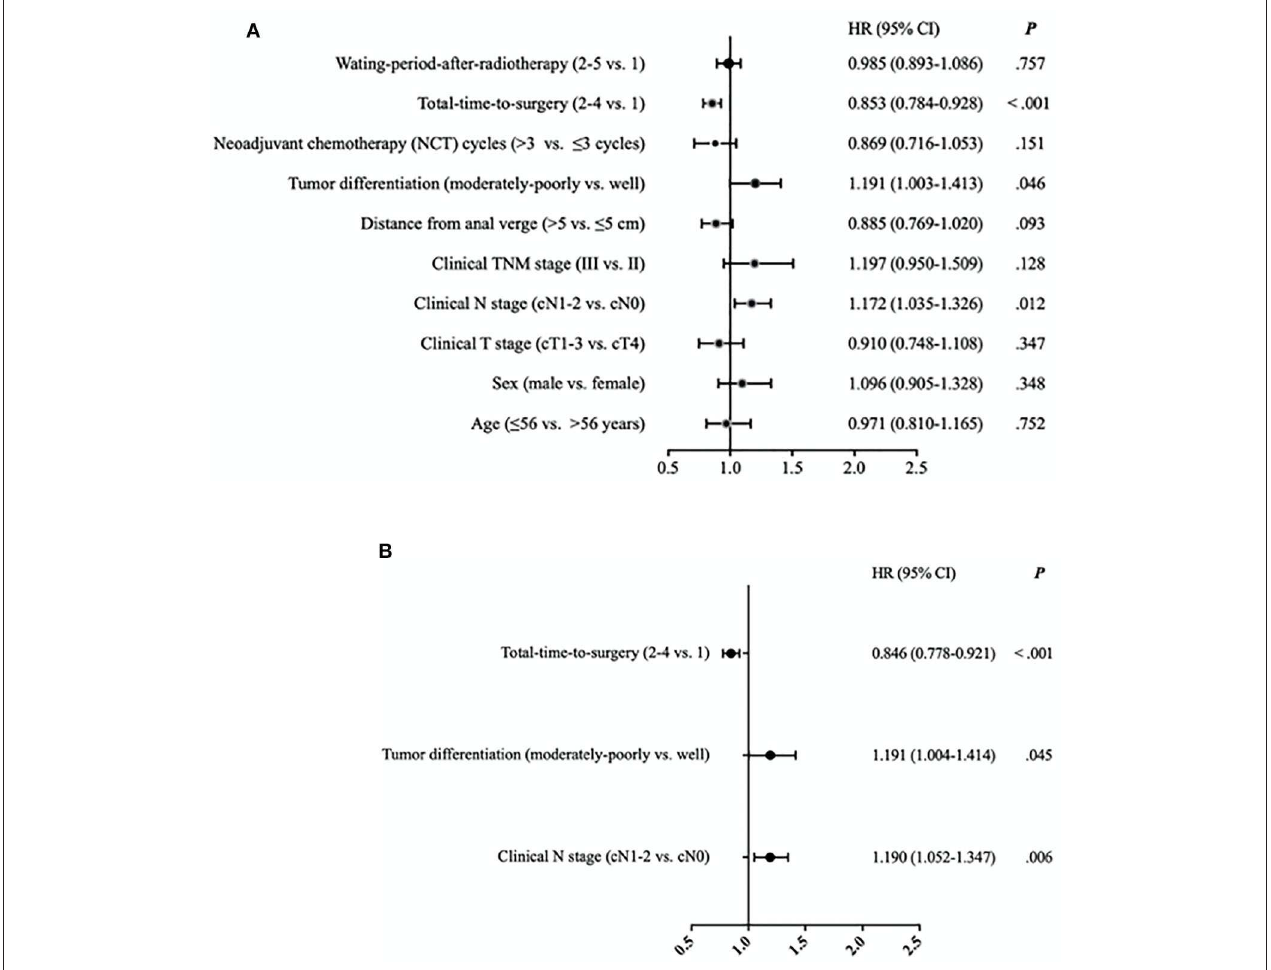
FIGURE 2 | (A) Univariate analysis of risk of disease relapse (disease-free survival) for 2,267 patients with locally advanced rectal cancer. Hazard ratios (HR) with 95% confidence intervals (CI) on 3-year disease-free survival equate to relative risk of disease relapse. Waiting-period-after-radiotherapy (WPR) defined as time from end of radiotherapy to date of surgery: 4 to < 6 weeks (WPR-1), 6 to < 8 weeks (WPR-2), 8 to < 10 weeks (WPR-3), 10 to < 12 weeks (WPR-4), and ≥ 12 weeks (WPR-5). Total-time-to-surgery (TTS) defined as time from initiation of neoadjuvant treatment to date of surgery: < 13 weeks (TTS-1), 13 to < 15 weeks (TTS-2), 15 to < 17 weeks (TTS-3), and ≥ 17 weeks (TTS-4). (B) Multivariate analysis of risk of disease relapse (disease-free survival) for 2,267 patients with locally advanced rectal cancer. Hazard ratios (HR) with 95% confidence intervals (CI) on 3-year disease-free survival equate to relative risk of disease relapse. Total-time-to-surgery (TTS) defined as time from initiation of neoadjuvant treatment to date of surgery: < 13 weeks (TTS-1), 13 to < 15 weeks (TTS-2), 15 to < 17 weeks (TTS-3), and ≥ 17 weeks